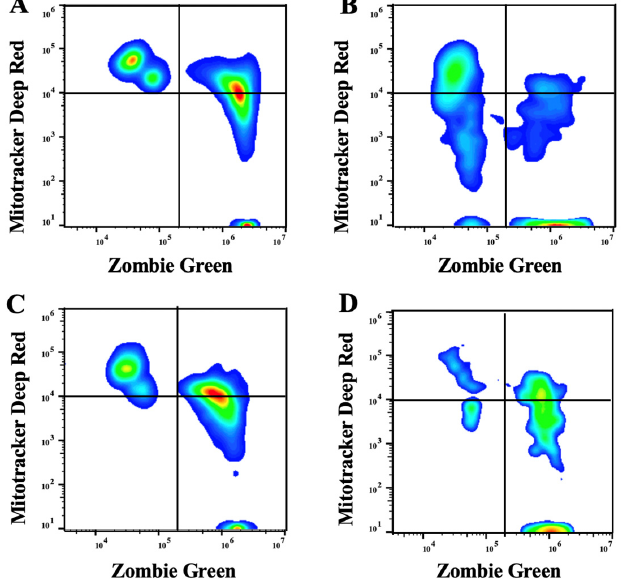
Figure 3. Representative plots of flow cytometric analyses from donkey ( A , B ) and horse ( C , D ) epididymal sperm. Sperm was obtained via retrograde flushing of the tail of the epididymis ( A , C ) followed by slicing float-up ( B , D ). Sperm was stained with Zombie Green and Mitotracker Deep Red to